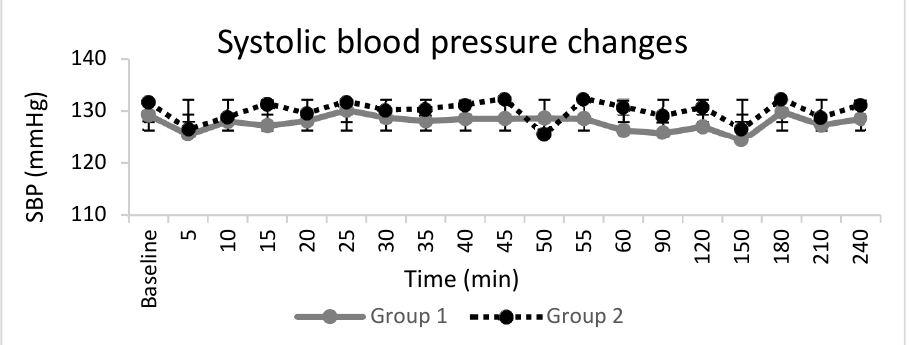
Figure 2. Overall onset of sensory block.